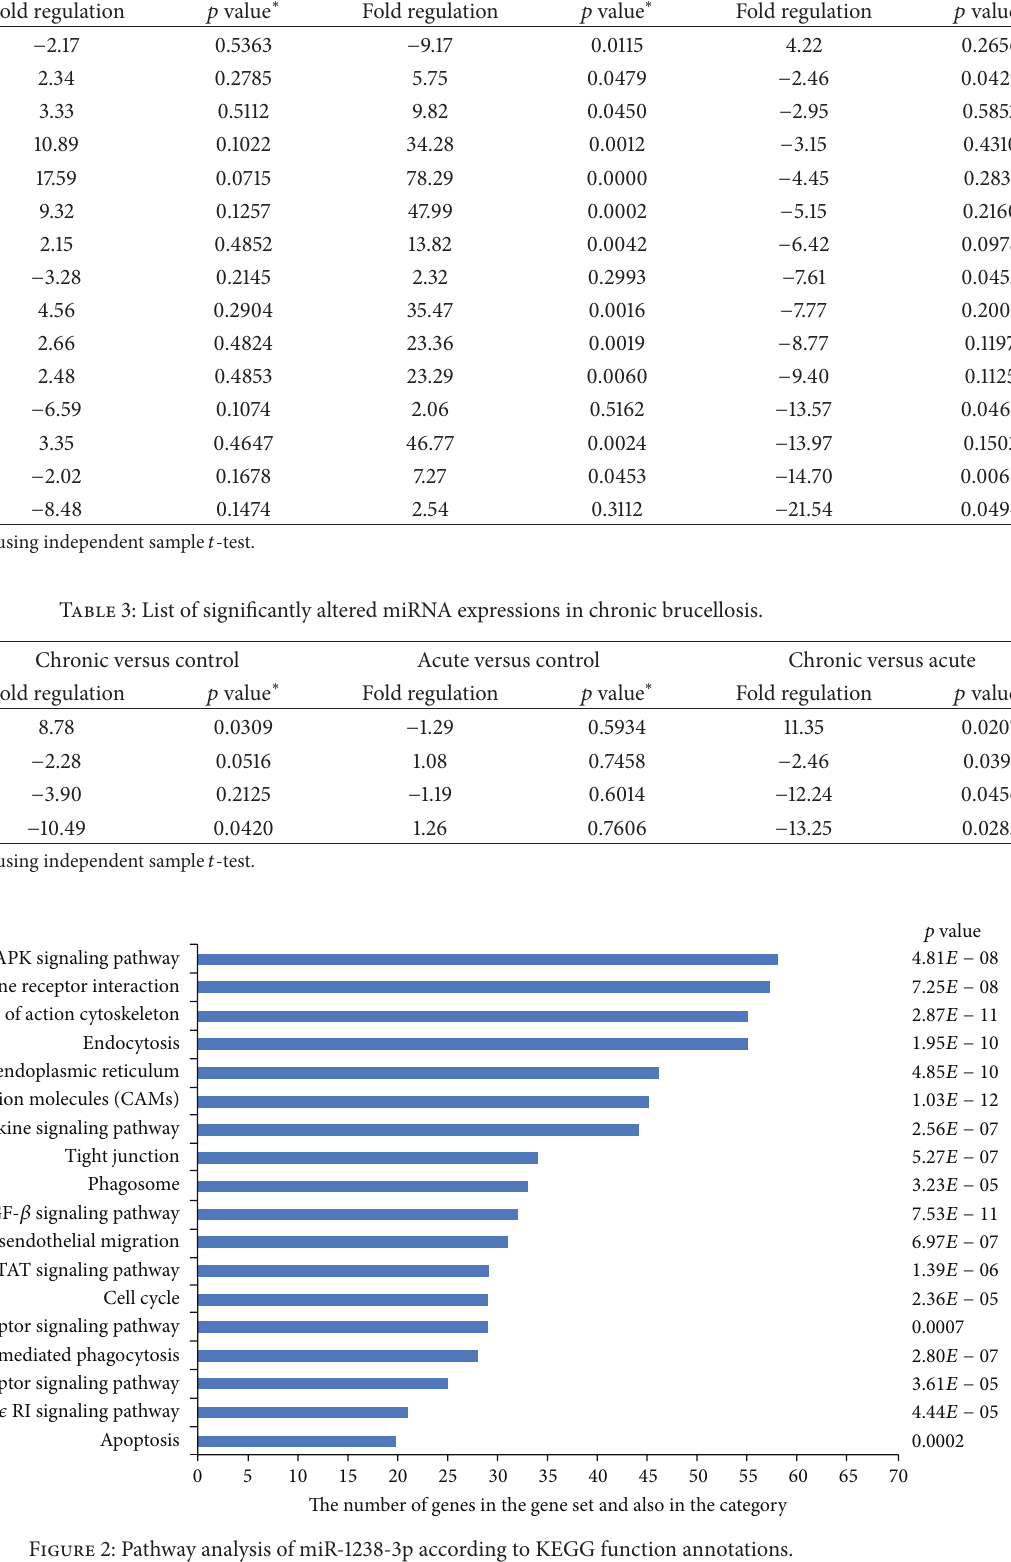
Figure 2: Pathway analysis of miR-1238-3p according to KEGG function